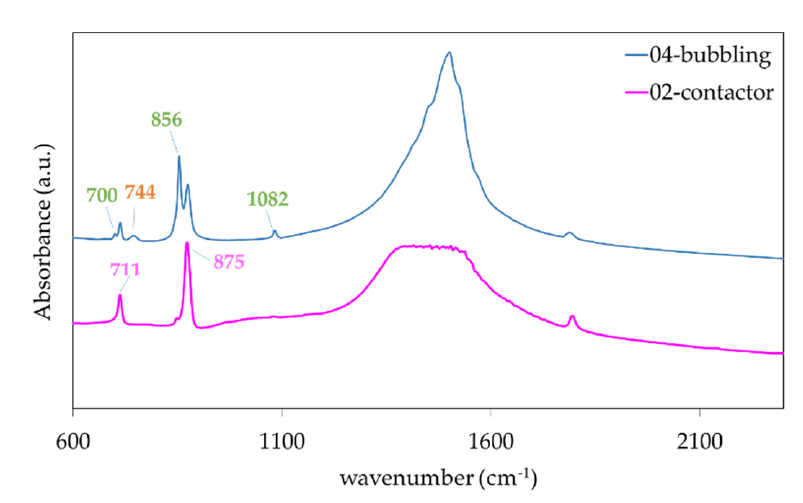
Figure 8. Fourier-Transform InfraRed (FTIR) spectroscopy results for samples obtained in bubbling mode (blue line) and contactor mode (pink line) exhibiting calcite, aragonite, and vaterite and only calcite peaks respectively.